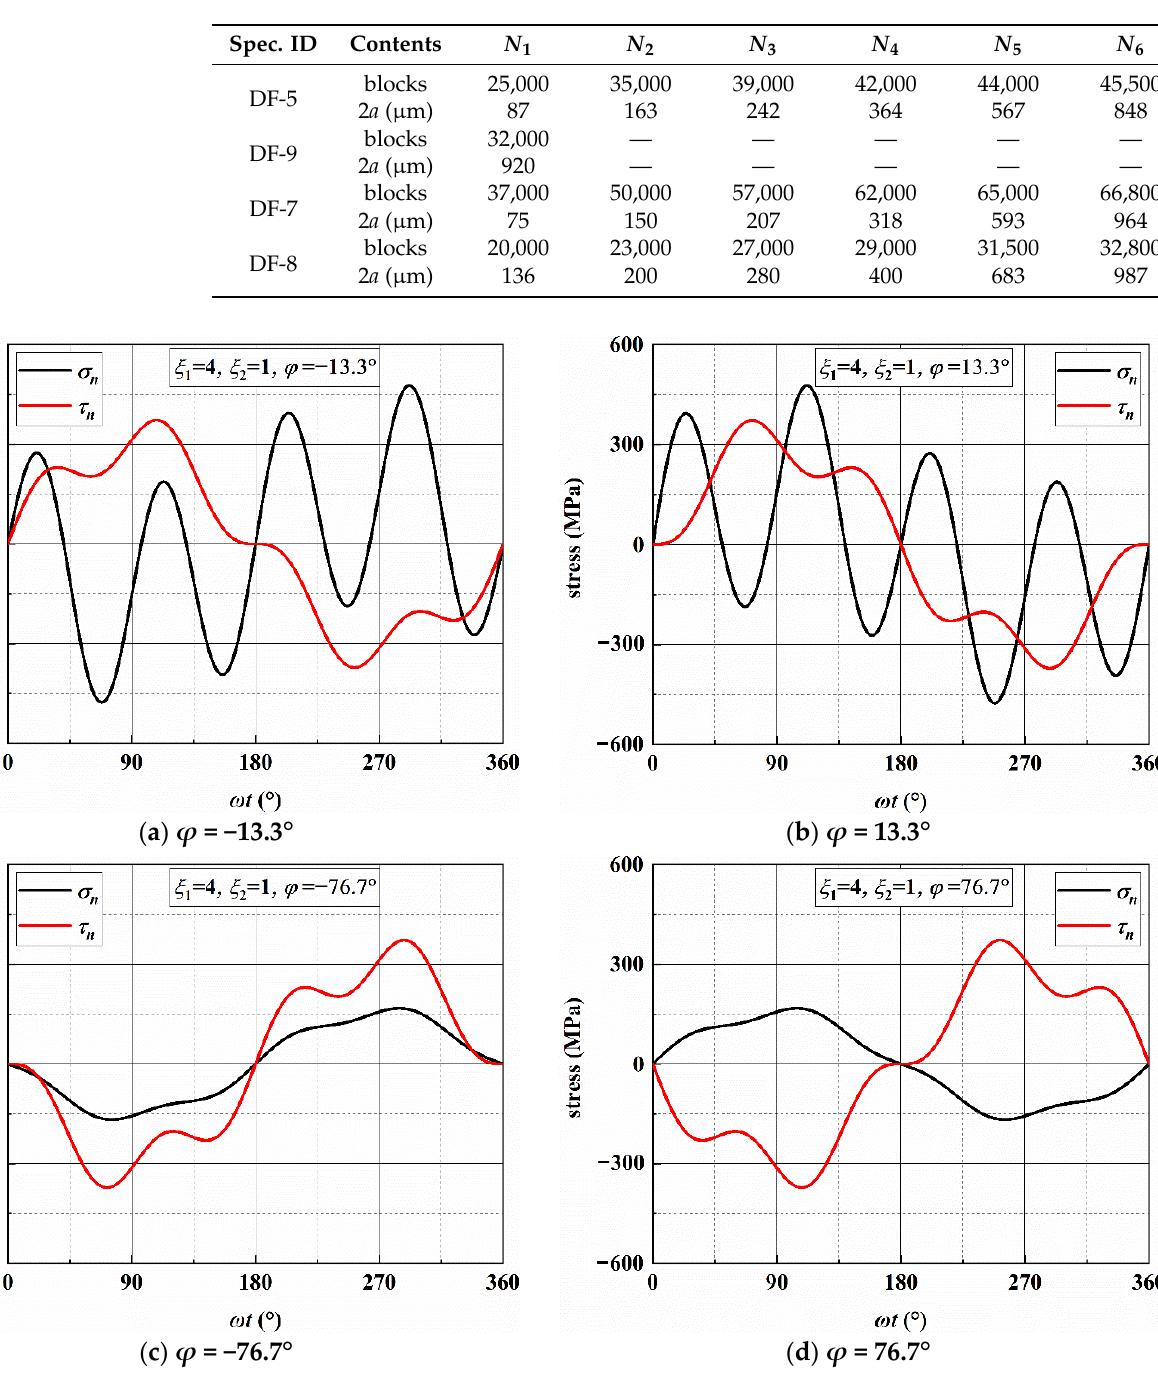
Figure A1. Variation of normal and shear stress on MSSA plane under AS-2.